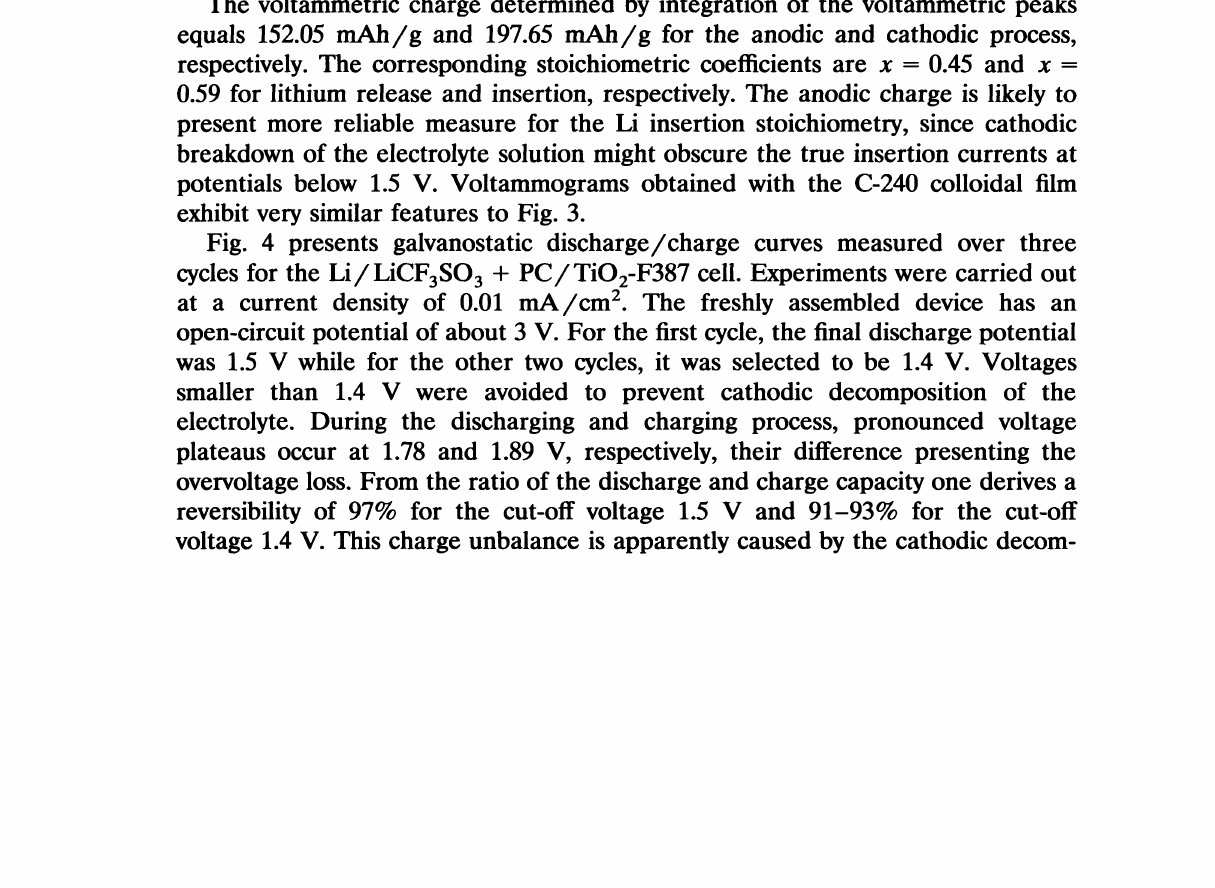
FIGURE 3 Cyclic voltammogram obtained with a nanoerystalline F-387 (Degussa) film electrode in 1 M LiCF3SO3-propylene carbonate electrolyte. Electrode area 0.95 cm 2, mass of TiO 2 1.803 mg, scan rate 0.1